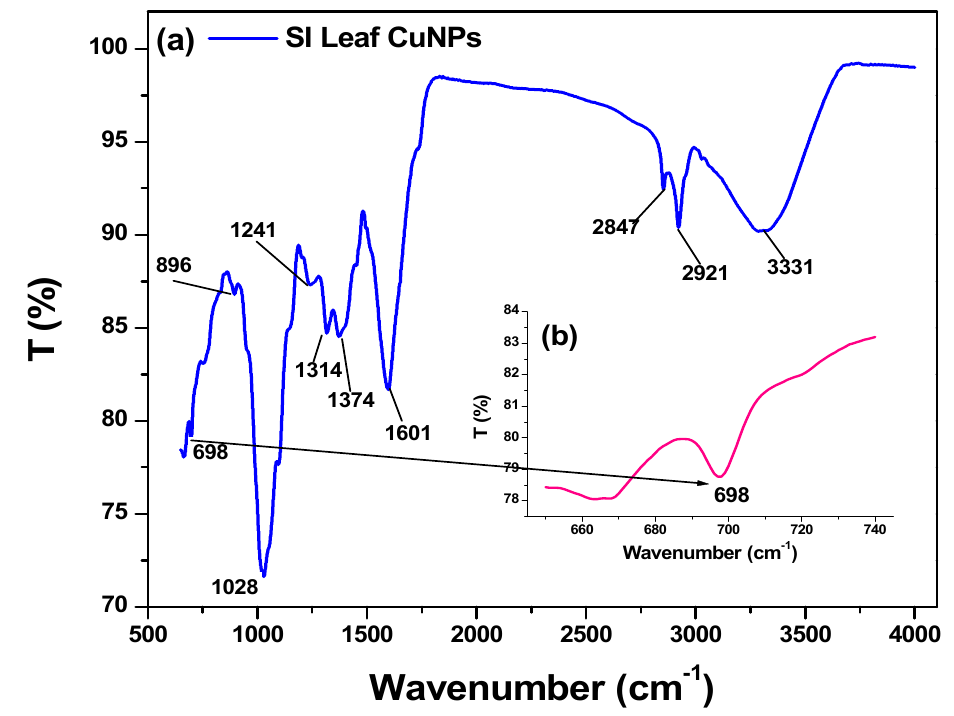
Figure 6. ( a ) FTIR spectrum of as-synthesized Cu 2 O nanoparticles using SI leaf extract and ( b ) specific Cu – O at 698 cm − 1